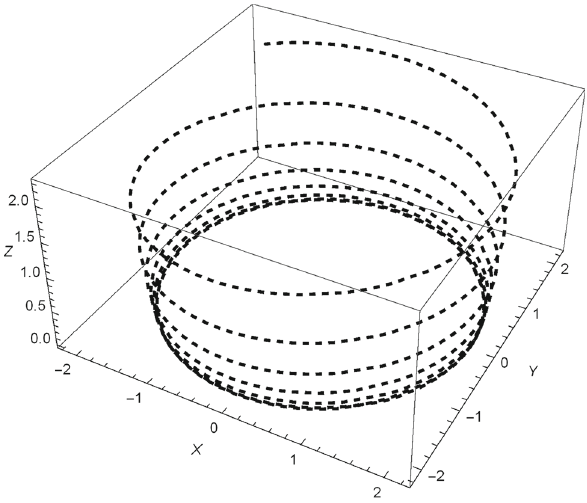
Fig. 6 Three-dimensional trajectoryfor b 0 = 1, n = 4 and β = 1 / 100